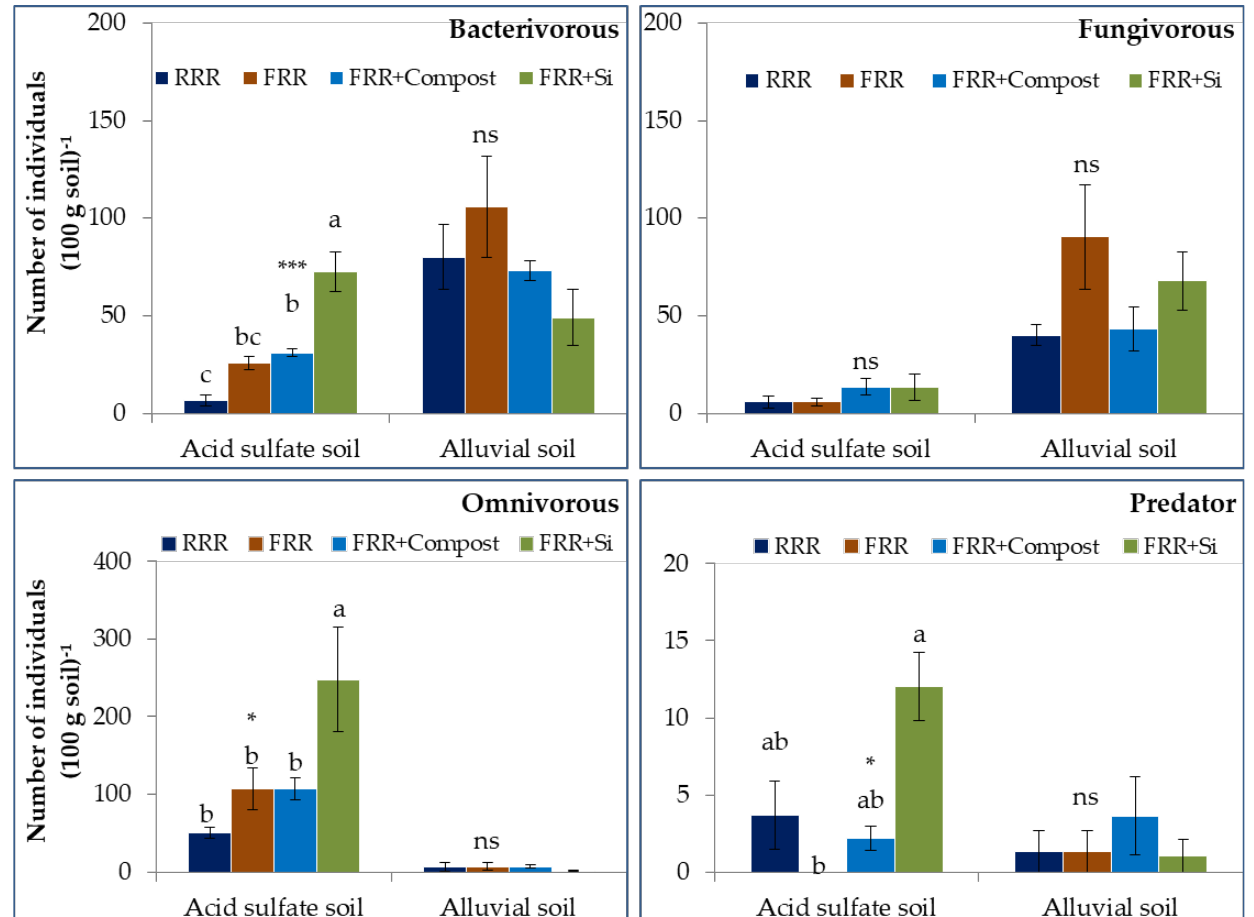
Figure 3. The abundance (mean ± standard error, n = 4) of the trophic structure of the free–living nematode community among treatments in the acid sulfate soil in Ben Tre province and the alluvial soil in Kien Giang province, Vietnam. The different letters indicate a significant difference among treatments at * p < 0.05; *** p < 0.001; ns, not significant. RRR, triple–rice system; FRR, fallow and double–rice; FRR + Compost, fallow and double–rice with 3 Mg ha –1 sugarcane filter cake compost; FRR + Si, fallow and double–rice with 100 kg ha –1 silicate fertilizer.